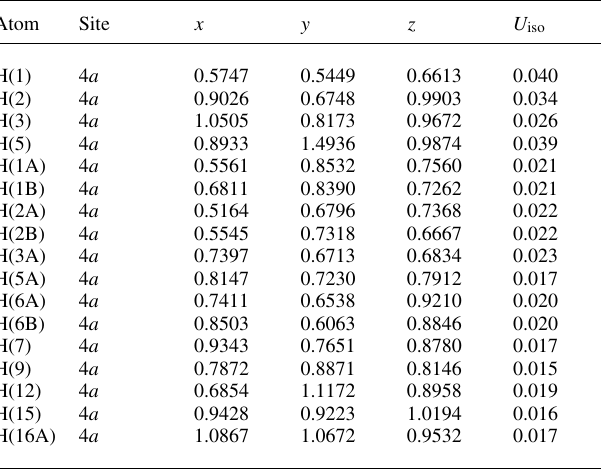
Table 2. Atomic coordinates and displacement parameters (in Å 2 ) .